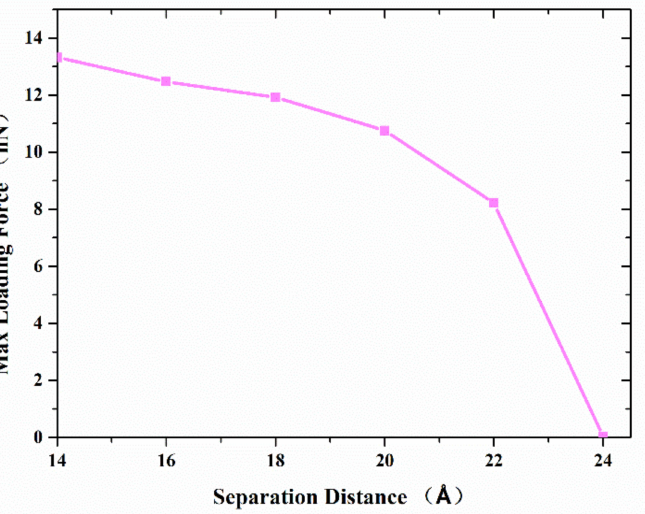
Figure 6. The maximum axial force that the interface can resist with the separation